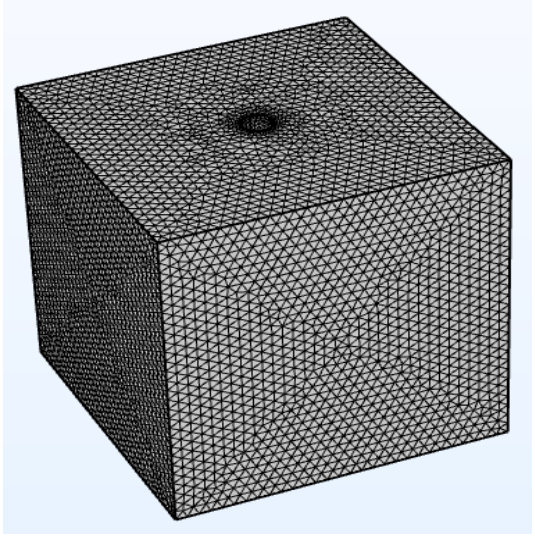
Figure 5. A representation of the mesh surrounding the shaft.